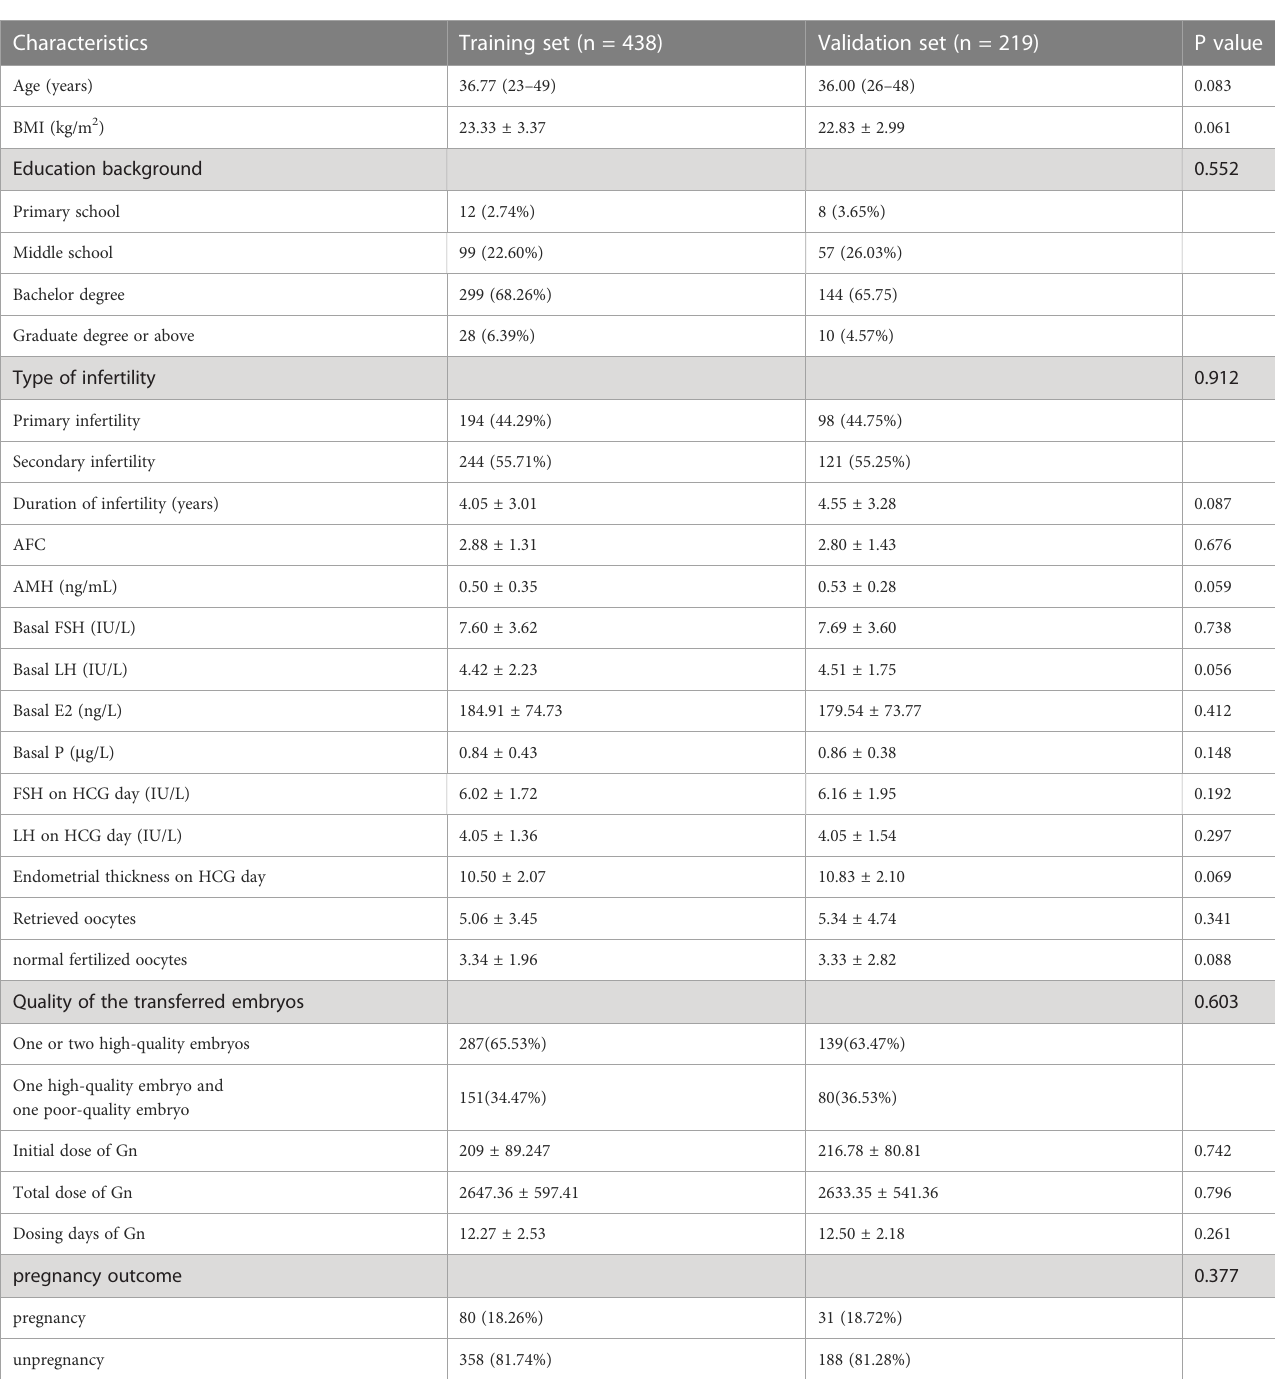
TABLE 1 Baseline characteristics of study